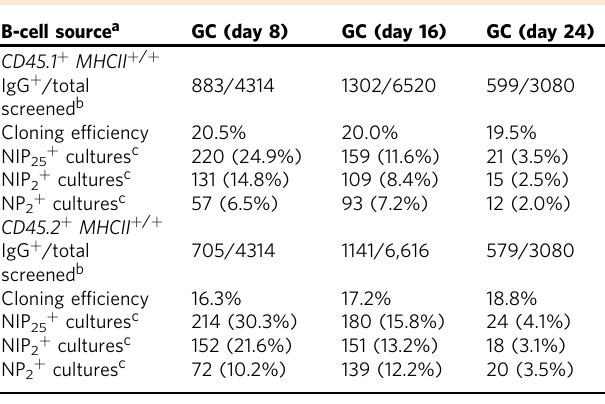
Splenic GC B cells from BM chimera mice were single-sorted into Nojima cultures for in vitro clonal expansion and plasmacytic differentiation on days 8, 16, and 24 after NP-OVA/Alum immunization.Frequenciesandoftotal-andspeci fi cIgGinculturesupernatantsweredetermined by ELISA and Luminex assays a GC B cells were sorted from either CD45.1 + MHCII + / + or CD45.2 + MHCII + / – population at indicated time points b Number of IgG positive samples/number of samples screened c Number of Ag-binding IgG positive